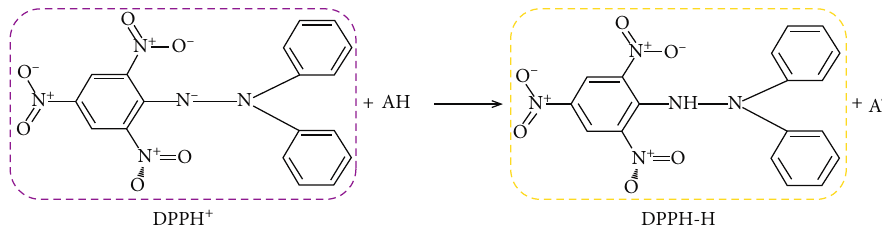
Figure 1: Reaction mechanism involved in the DPPH test between the free radical species DPPH • and an antioxidant (AH). Table 1: Concentration providing 50% DPPH radical scavenging (IC 50 ) and TAC of polyphenol extracts after adsorption onto ghassoul. PPW PPM PPA AA Concentration of polyphenols (g/L) 0.89 ± 0.00 — IC 50 ( μ